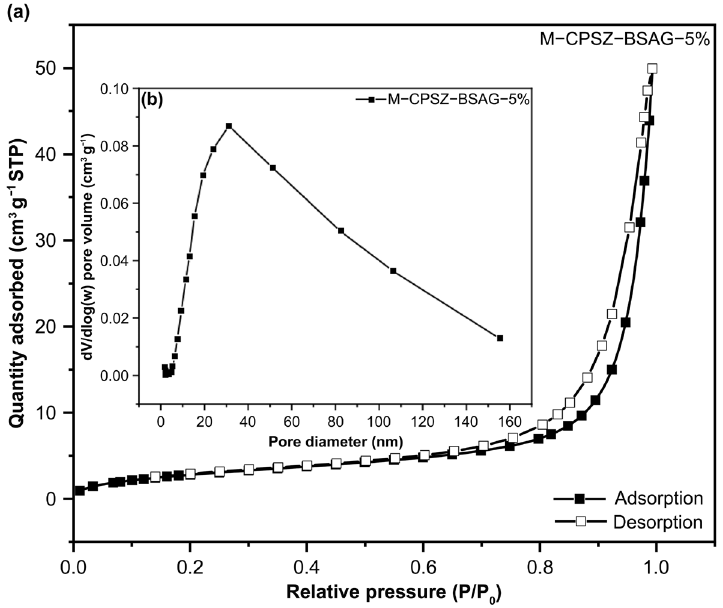
Figure 7. ( a ) Nitrogen adsorption–desorption isotherm and ( b ) pore size distribution of the ceramic aerogel composite (pyrolysis at 1000 °C). Table 3. Pore structure data (characterized by the BET method) of the ceramic aerogel composite (pyrolyzed at 1000 °C).